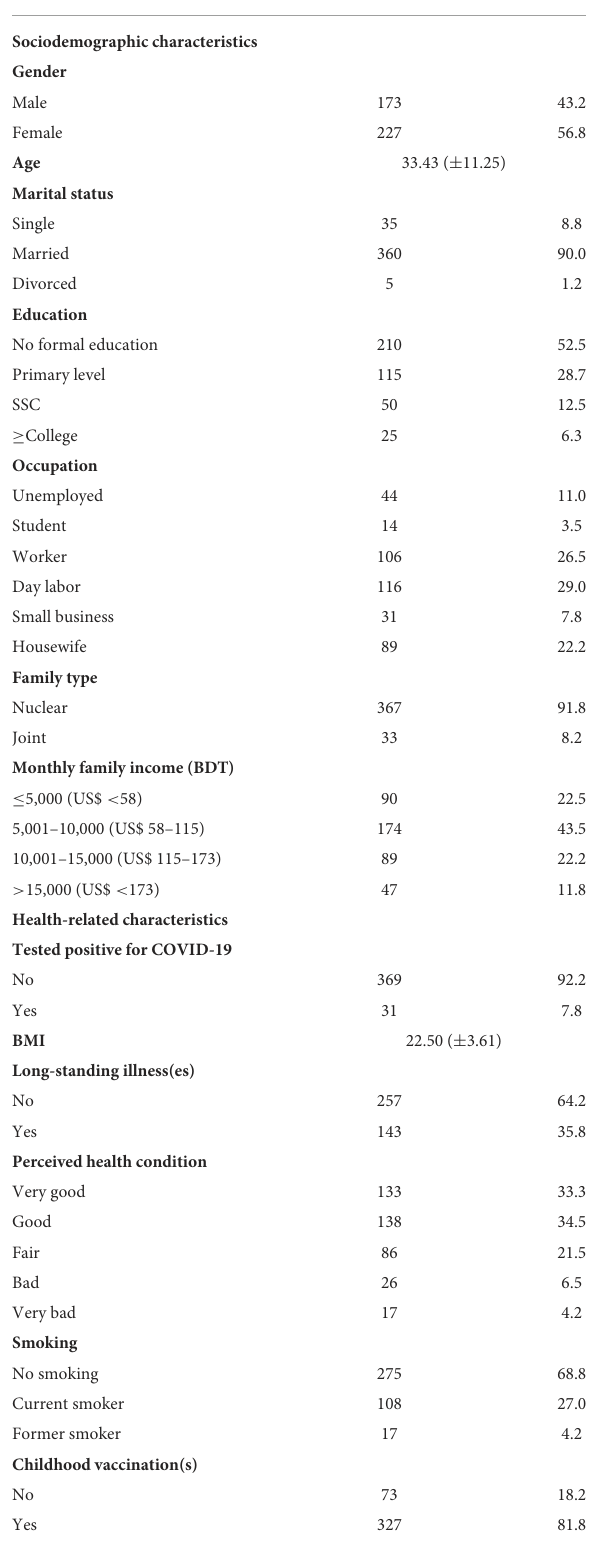
TABLE 1 Descriptive statistics of respondents’ intention to get vaccinated against COVID-19 ( N =